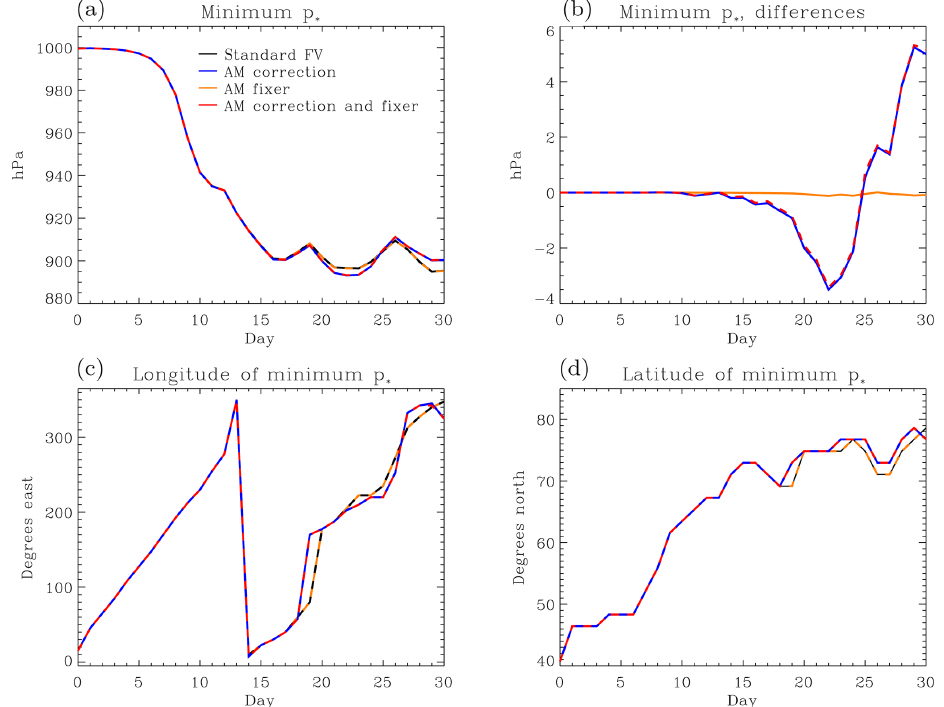
Figure 5. AM correction and fixer in an adiabatic, frictionless baroclinic wave test. Evolution of minimum pressure (a) and its position (c, d) in the baroclinic wave evolution from the integrations shown in Fig. 3. The colour coding of the lines is the same as in Fig. 3. Panel (b) shows the differences in minimum pressure between the AM experiments and FV control, with the same colour coding as in the lower curves in Fig. 4.